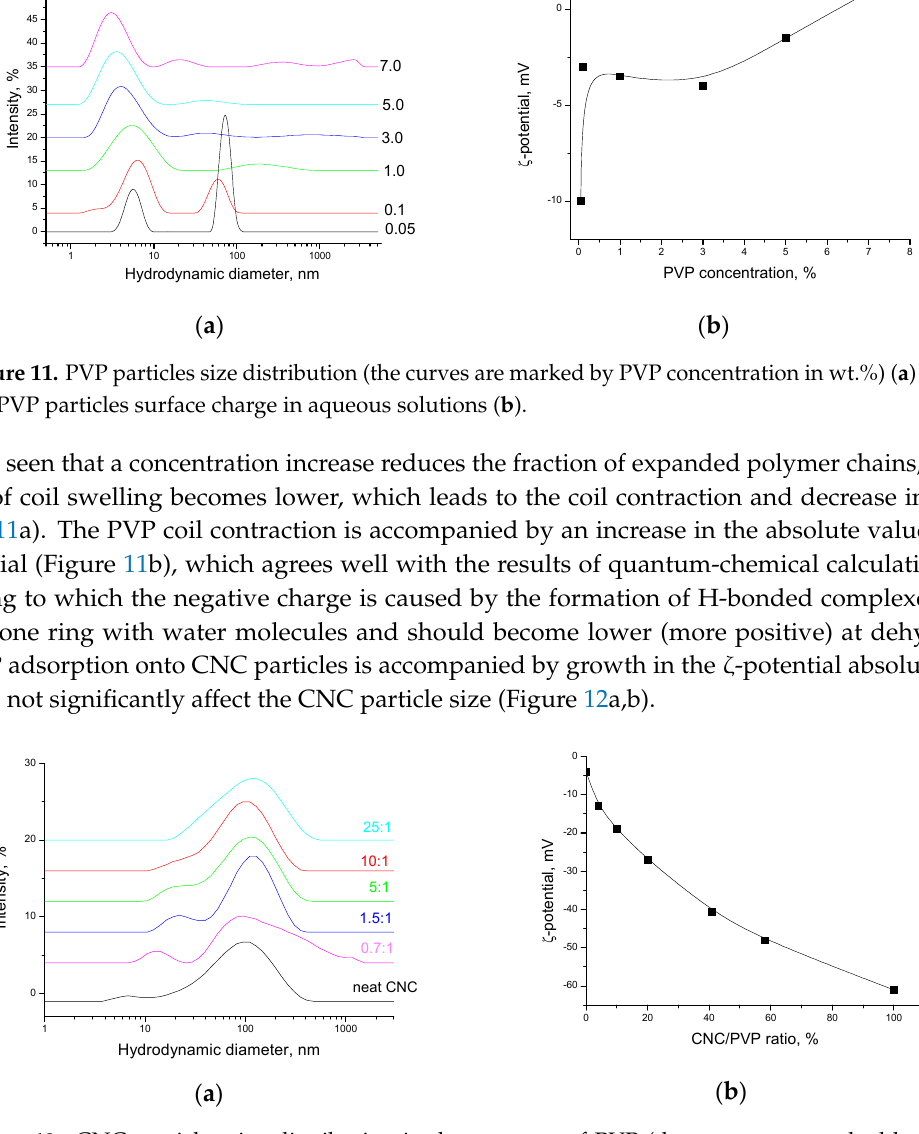
Figure 12. CNC particles size distribution in the presence of PVP (the curves are marked by the PVP/CNC concentration ratio) ( a ) and the CNC particles surface charge in aqueous suspensions (the CNC concentration of 0.07 wt.%) in the presence of PVP ( b ).